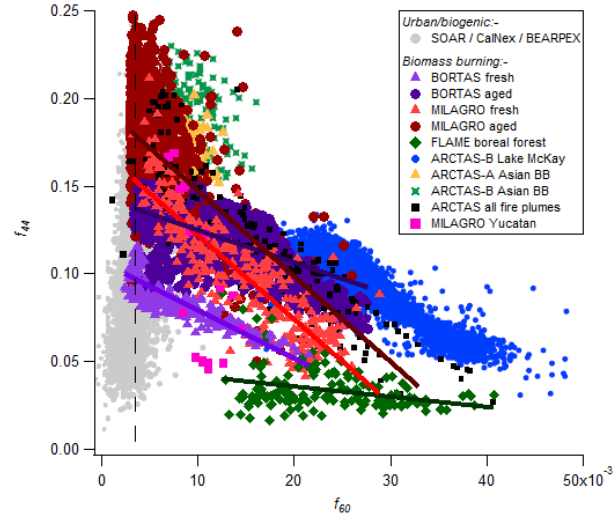
Figure 9. Synthesis of f 44 vs. f 60 from a range of ambient and laboratory measurements of BBOA, along with data from non-BB sources. The specified background f 60 value of 0.003 used to iden- tify BB influences is shown as the dashed vertical line. Coloured lines denote linear regressions for corresponding data sets. Adapted from Cubison et al.